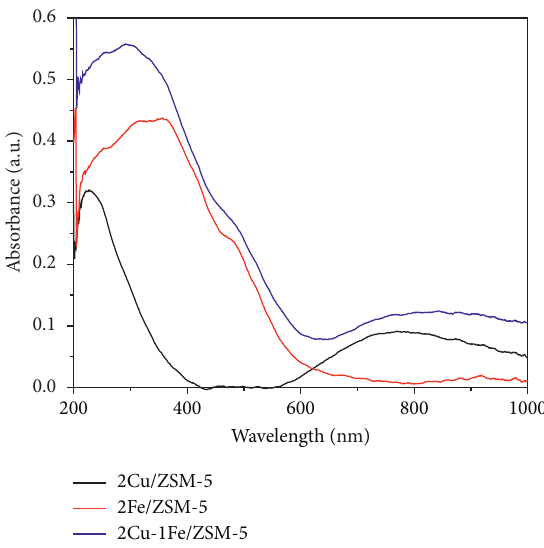
Figure 7: UV-Vis DRS spectra of the